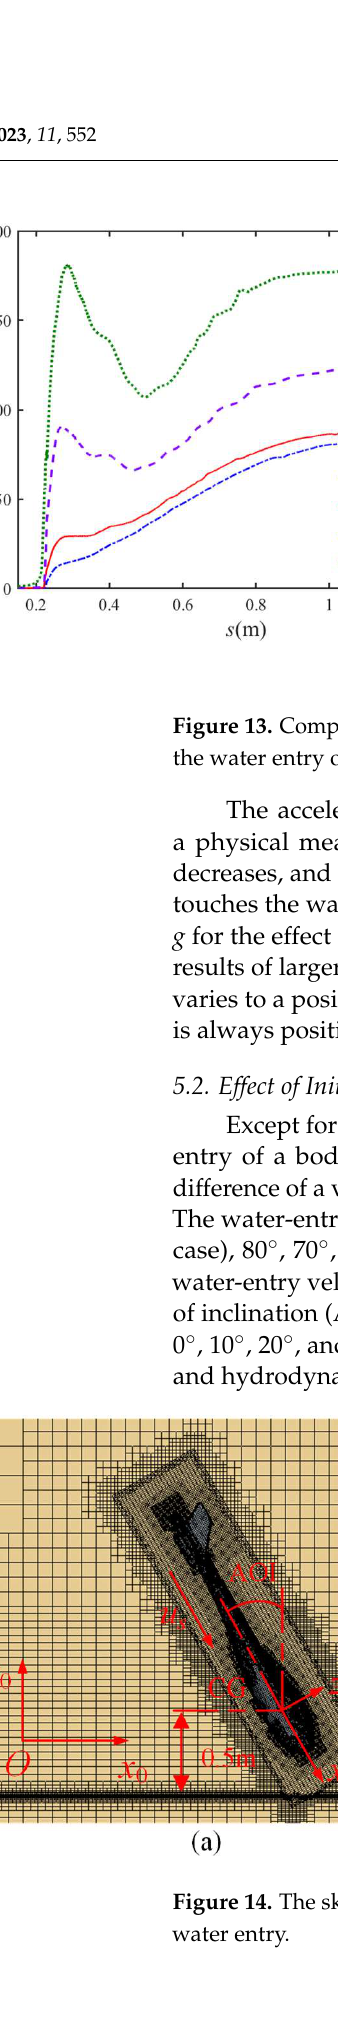
14 of 21 Figure 12. Comparison of the time history curve of monitored pressure for water entry of UAUV with various initial velocities. The vertical force and vertical acceleration for different initial velocities are given in Figure 13a,b. Here, the vertical force Z 0 equals the transverse force in the body-fixed coor- dinate. As can be seen, the simulated acceleration curves from the four cases coincide with the force curves for the same case during the whole water-entry process. In addition, pres- sure and force with higher W s are entirely larger than with lower W s . Notably, the force Z 0 is always positive throughout the whole water entry due to the slamming effect. This may be because more active turbulence dynamics are caused by larger induced velocity. When s is small, the local deadrise angle is smaller, thus leading to higher pressure peaks and high loads. The slamming force is normally proportional with quadratic velocity as indi- cated by Von Karman [6]. After the peak slamming force, the vertical hydrodynamic force decreases rapidly until it drops to the minimum positive value and then climbs up again,